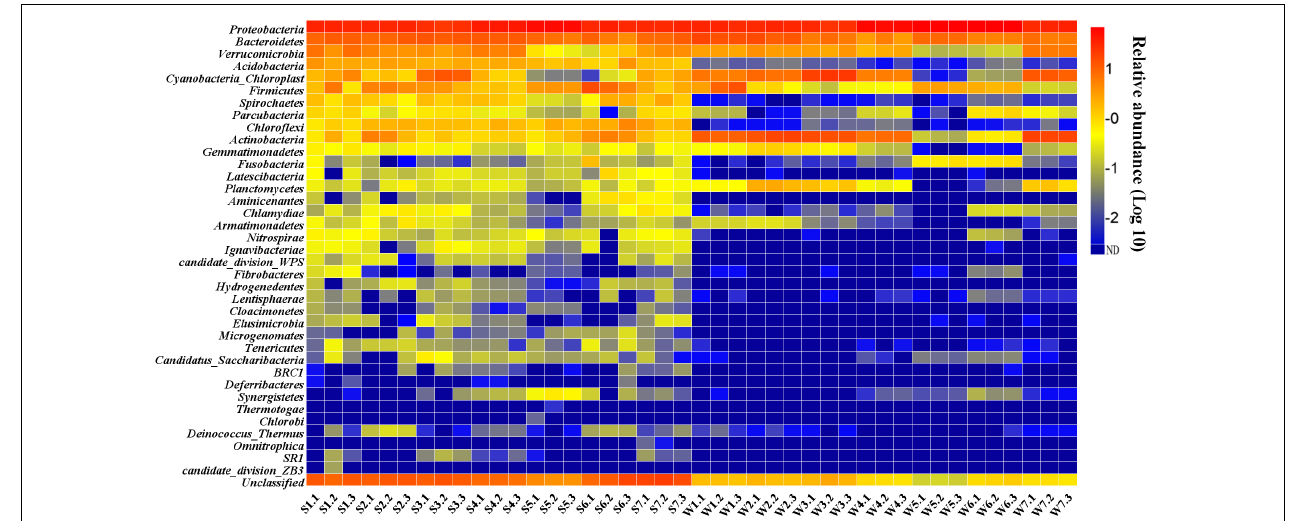
FIGURE 3 | Percentage of different phyla in the water and